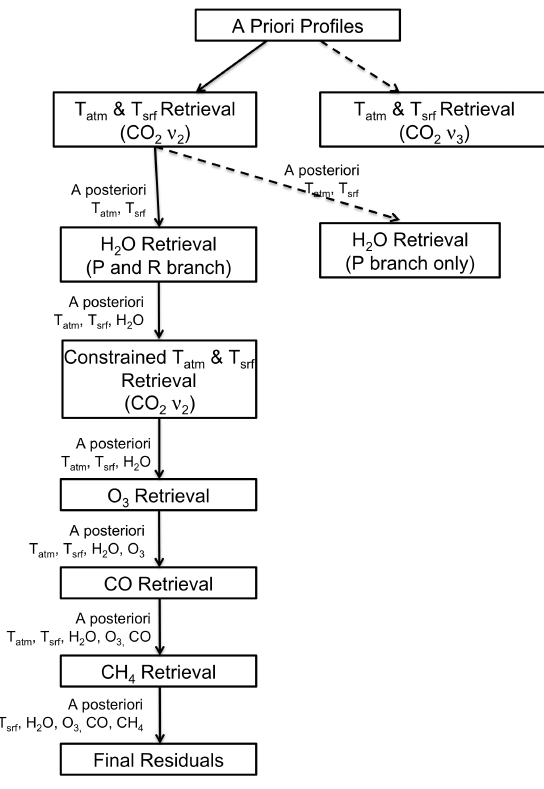
Fig. 1. Schematic of the retrieval procedure used in this study. Solid arrows show the main line from the a priori profiles described in Sect. 4 to the final residuals for the two models (LBLRTM v12.1 and LBLRTM v9.4 + ) . The dashed lines show additional retrievals done to assess the consistency of the spectroscopy between the ν 2 and ν 3 bands of CO 2 and the P- and R-branches of H 2